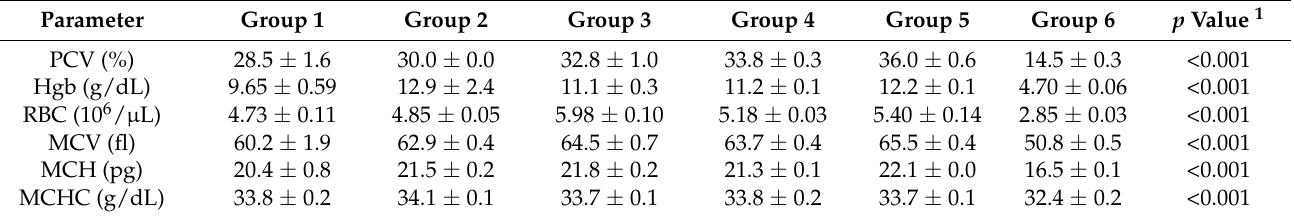
Table 4. Hematological indices of experimental animals. The data represent the mean ± standard error of n = 6 independent